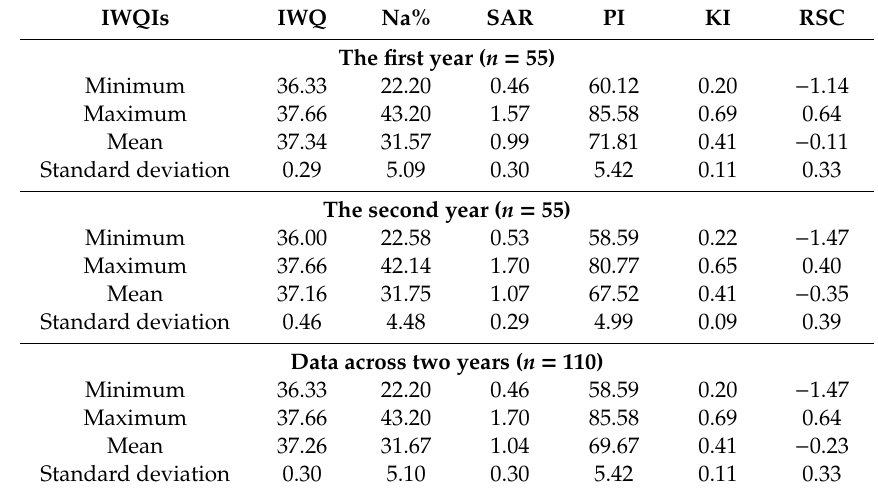
Table 4. Statistical description of the six Water Quality Indices (WQIs) in the northern Nile Delta.